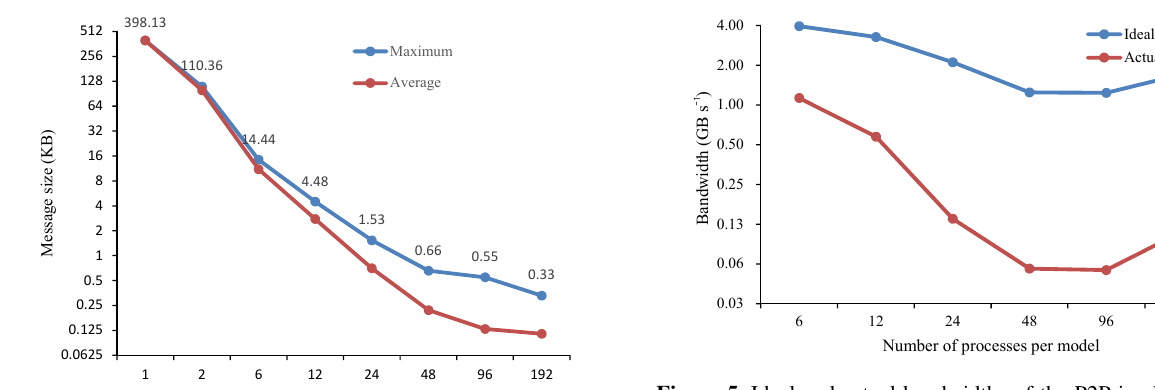
Figure 5. Ideal and actual bandwidths of the P2P implementation ( y axis) in GAMIL2–CLM3 when gradually increasing the number of processes per model ( x axis). The experimental set-up is similar to that shown in Fig. 1. The ideal bandwidth is calculated from the message size and the MPI bandwidth measured in Fig. 2; and the actual bandwidth is calculated from Fig.